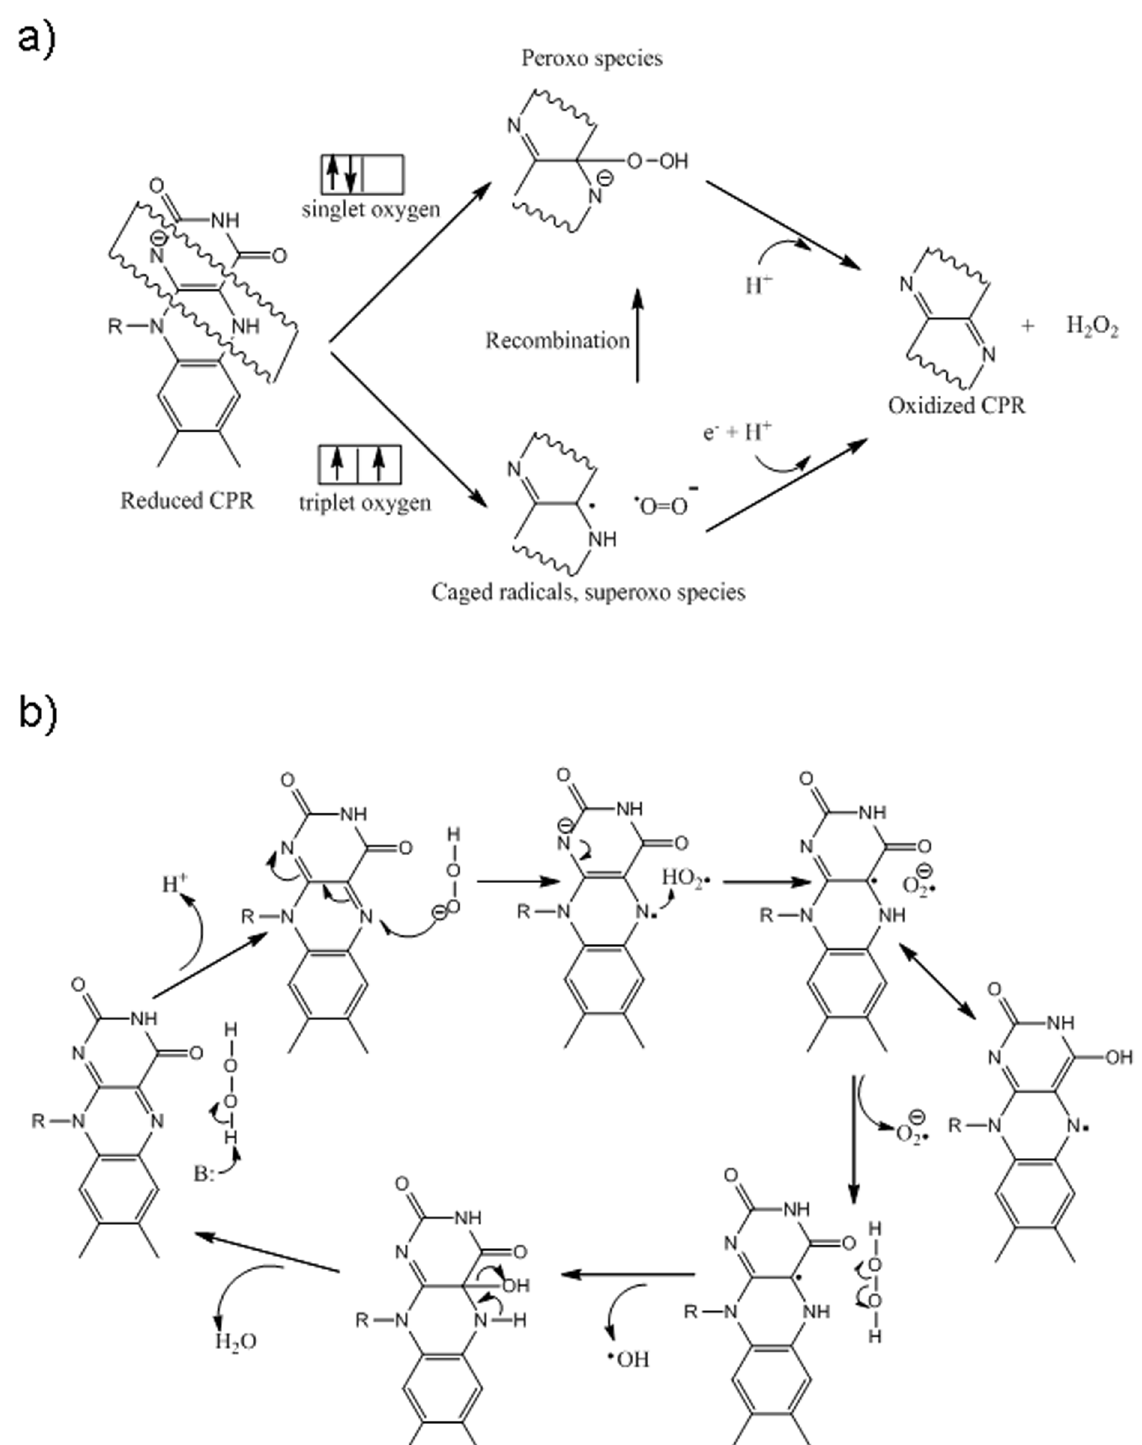
Figure 5. Molecular mechanisms of oxygen activation and peroxide depletion by CPR. 5a.ActivationofoxygenbyreducedCPRto generateDROS.5b:Probableflavin-basedmechanisticroutefordegradationofperoxide .